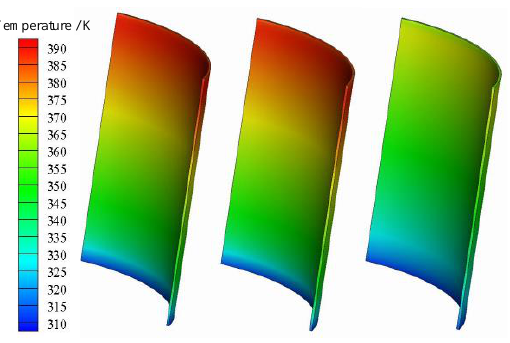
Figure 3. Temperature distribution of Encapsulation Layers 19–21.